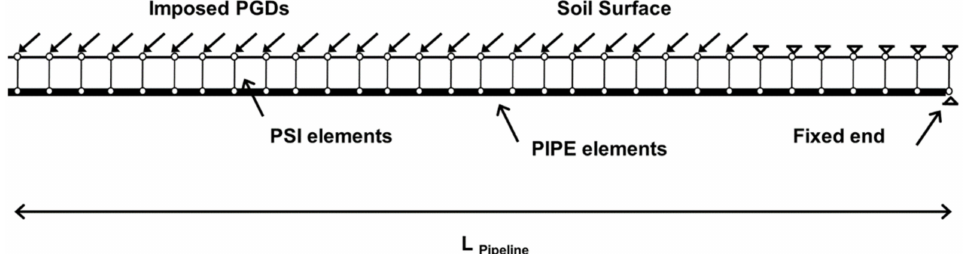
Figure 4. Numerical modeling of a buried pipeline and pipe–soil